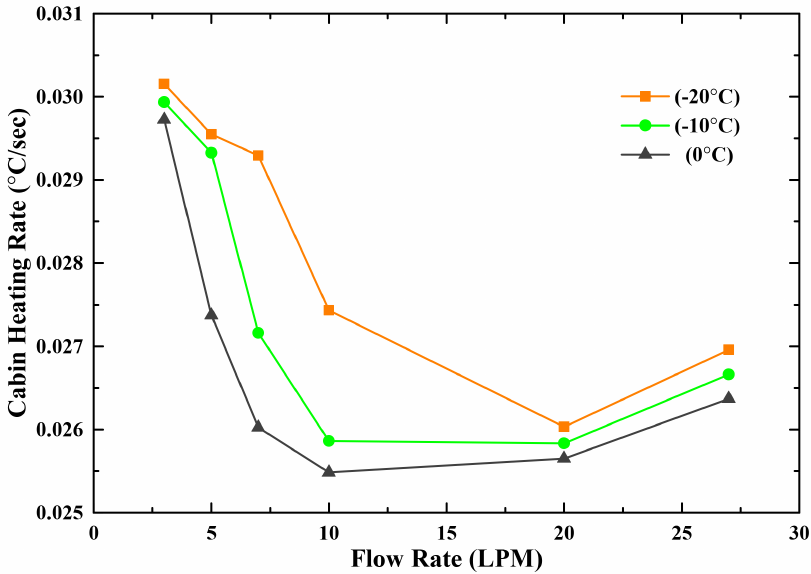
Figure 11. Cabin heating rate versus flow rate at 400 CMH airflow and heater capacity: 2 kW.